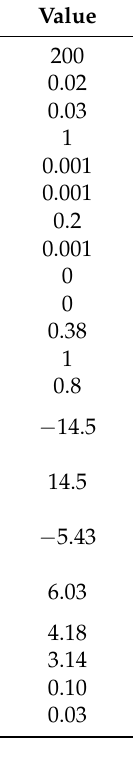
Table A3. Parameters of exciter type DC1A.